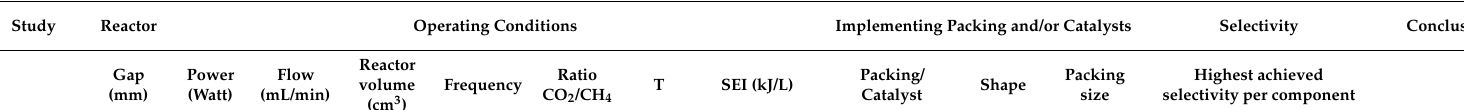
Table 1. Summary of a selection of literature for CO 2 splitting in a non-packed and a packed DBD reactor.